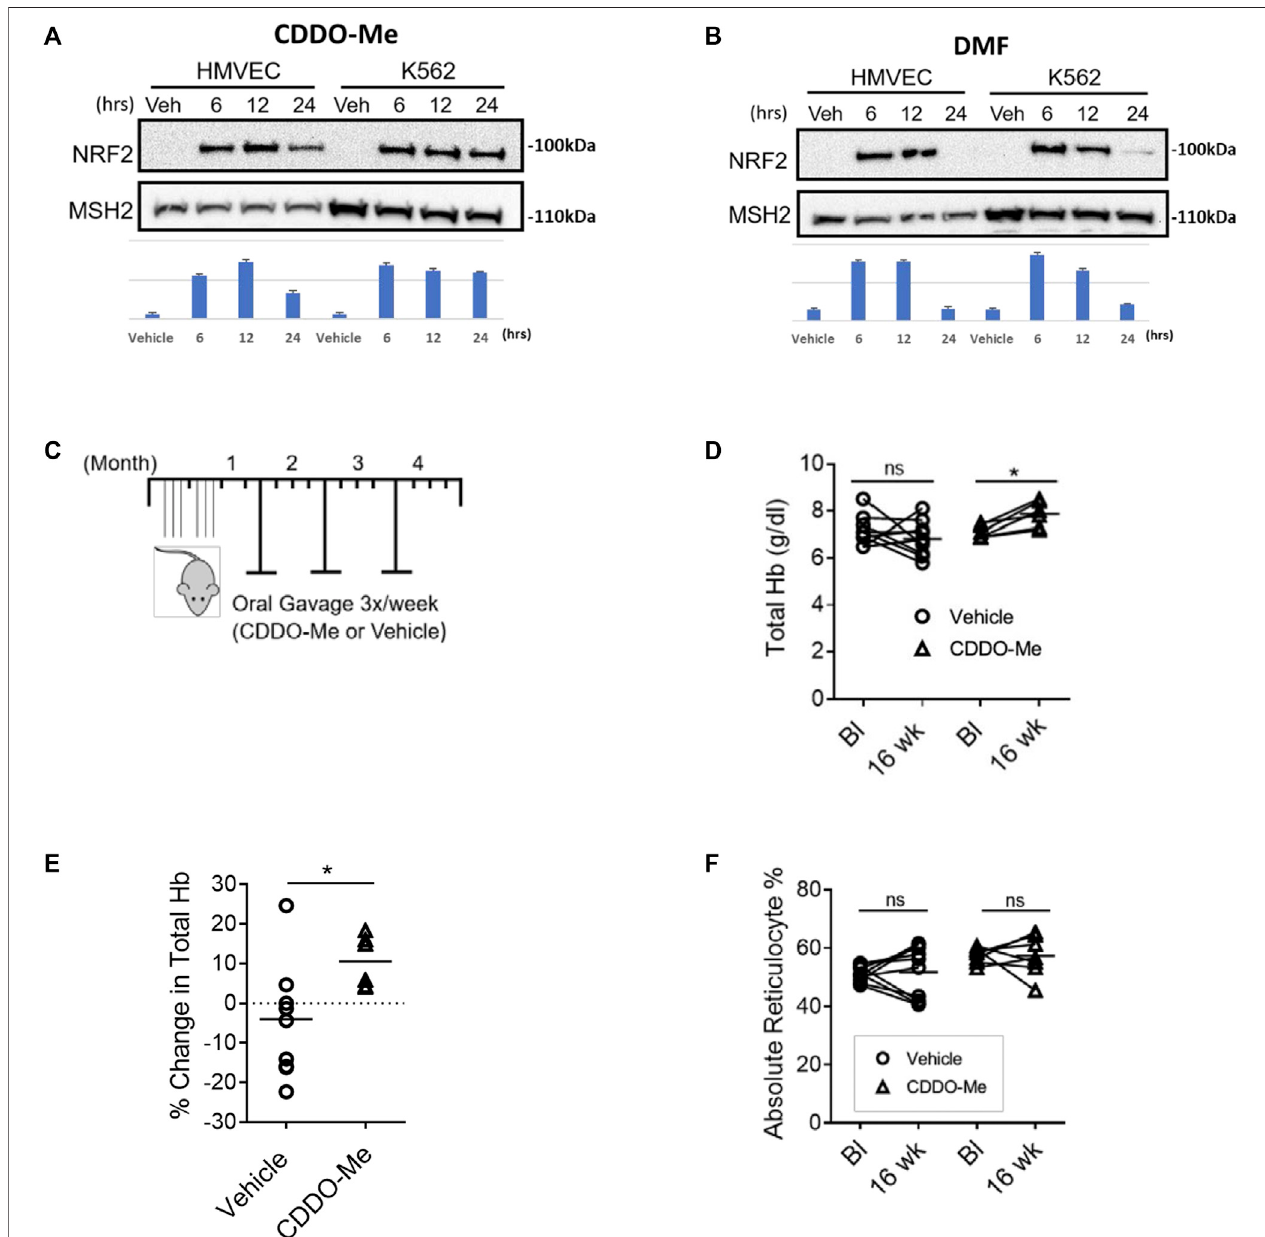
FIGURE 1 | CDDO-Me is a potent activator of endothelial and erythroid NRF2 in vitro and improves hemolytic anemia with aging in SS mice. (A,B) Immunoblots were used to assess drug speci fi c temporal differences in Nrf2 nuclear translocation in HMVEC and K562 cells. Quanti fi cation was done using NIH Image J processing with aribitrary units shown for the y -axis. Cells were cultured and treated with (A) CDDO-Me (100 nM) or vehicle, and (B) DMF (20 μ M) or vehicle for 6, 12, and 24 h. Subsequently, nuclear extracts were isolated and probed for NRF2 and the loading control mutS homolog 2 (MSH2). (C – F) SS mice were randomly chosen at 4 – 6 weeks ofage tobetreated for16 weekswithCDDO-Me(20 μ mol/kg) or vehicle (DMSO) byoralgavage. (C) Schematicillustrating theexperimentaldosing regimen inSSmice.Toassessdruginducedchangesinhematologicalchemistrywithaging,micewerephlebotomizedwithretro-orbitalbleedstocomparebaseline(Bl)valuesto values from the same mouse after 16 weeks (16 weeks). For total hemoglobin quanti fi cation, we used a portable Co-Oximeter. Pairwise changes in (D) absolute total hemoglobin values and (E) total hemoglobin percent change are shown ( n = 6 CDDO-Me group, n = 10 vehicle group, p p < 0.05, Student ’ s t-test). (F) For reticulocyte quanti fi cationweusedaHeskaHemaTrueanalyzertocomparebaselineand16-weekvaluesforSSmicetreatedwithCDDO-Me(20 mmol/kg)orvehicle(DMSO)byoral gavage. Pairwise changes in absolute reticulocyte percentage values are shown ( n = 6 CDDO-Me group, n = 10 vehicle group, p p < 0.05, Student ’ s t-test).